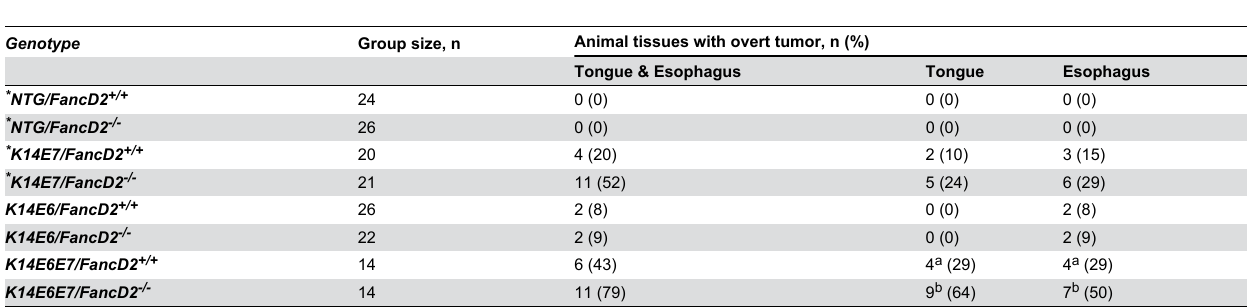
Table 1. Comparison of 4NQO induced overt tumor incidences in the mouse tongue and esophagus tissues.